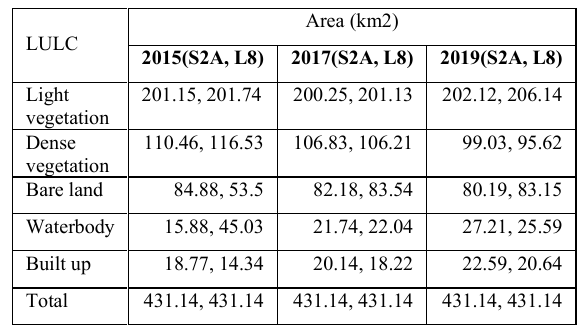
Table 3: Landsat-8 OLI and Sentinel 2A image